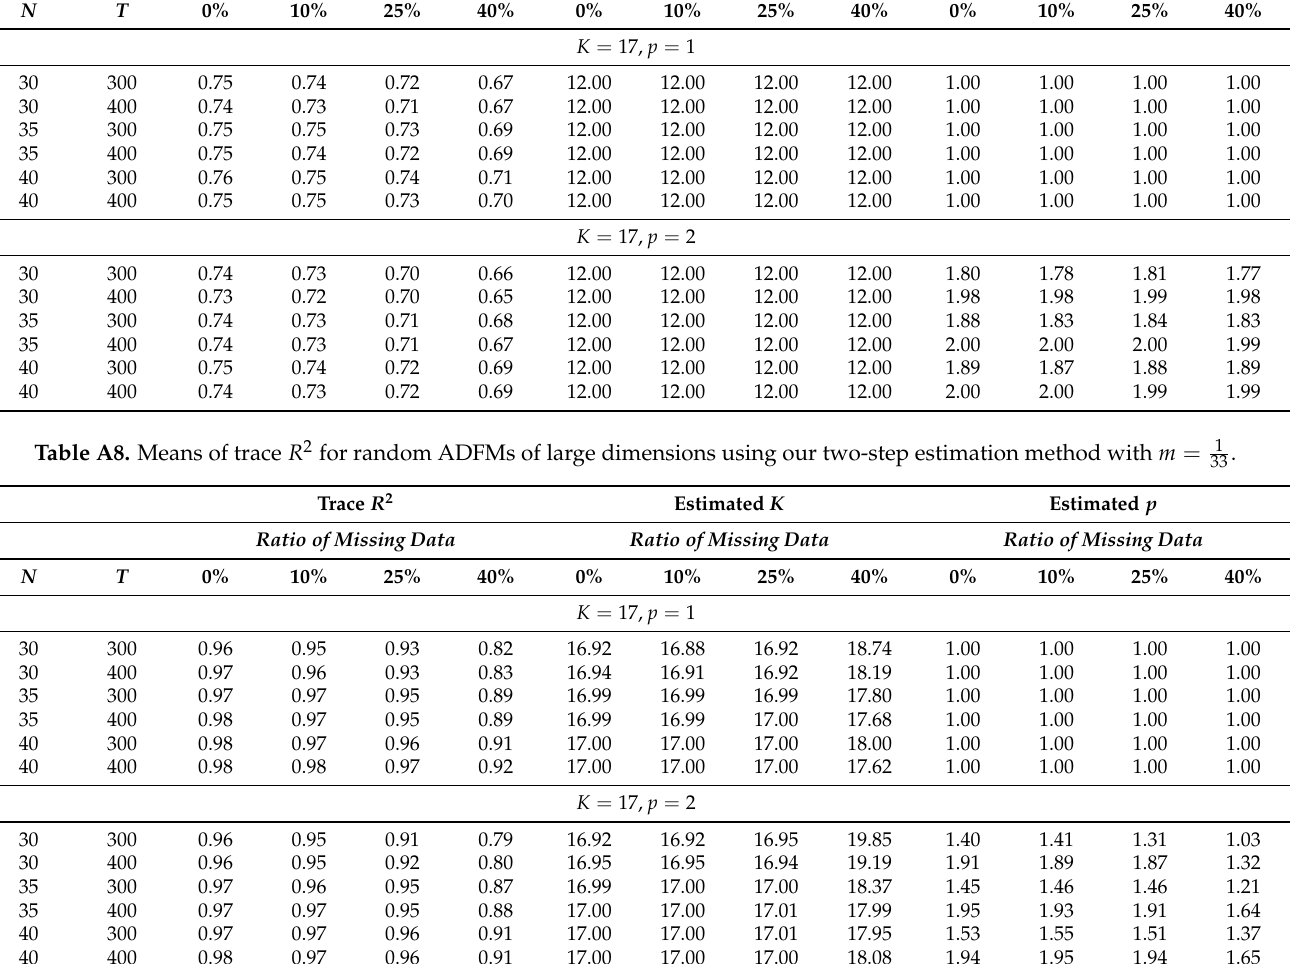
Table A9. Means of trace R 2 for random ADFMs of large dimensions using our two-step estimation method with m = 1